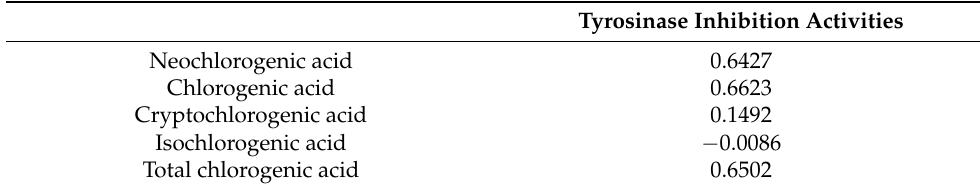
Table 5. The Pearson correlation coefficients (r) between the total and individual chlorogenic acid contents and the tyrosinase inhibition activities.